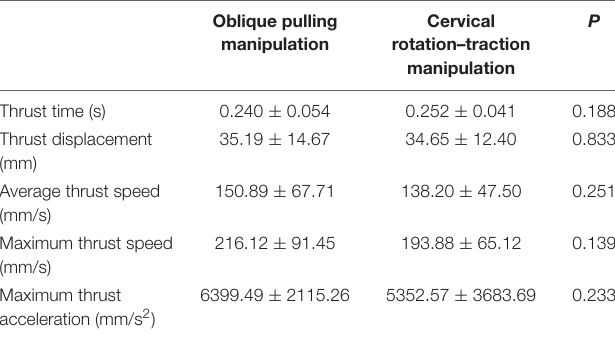
TABLE 2 | Comparison of kinematic parameters of participants between the two groups. Oblique pulling manipulation